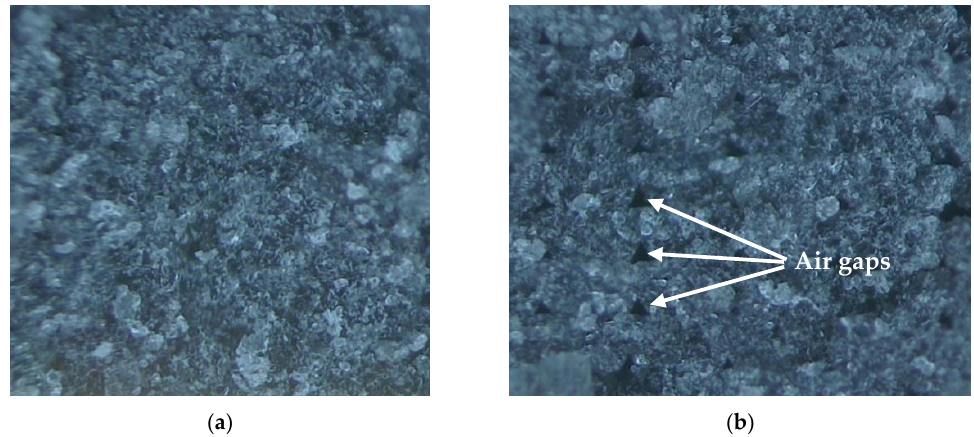
Figure 6. Microscopic images: ( a ) the layer thickness of 0.1 mm; ( b ) the layer thickness of 0.3 mm.